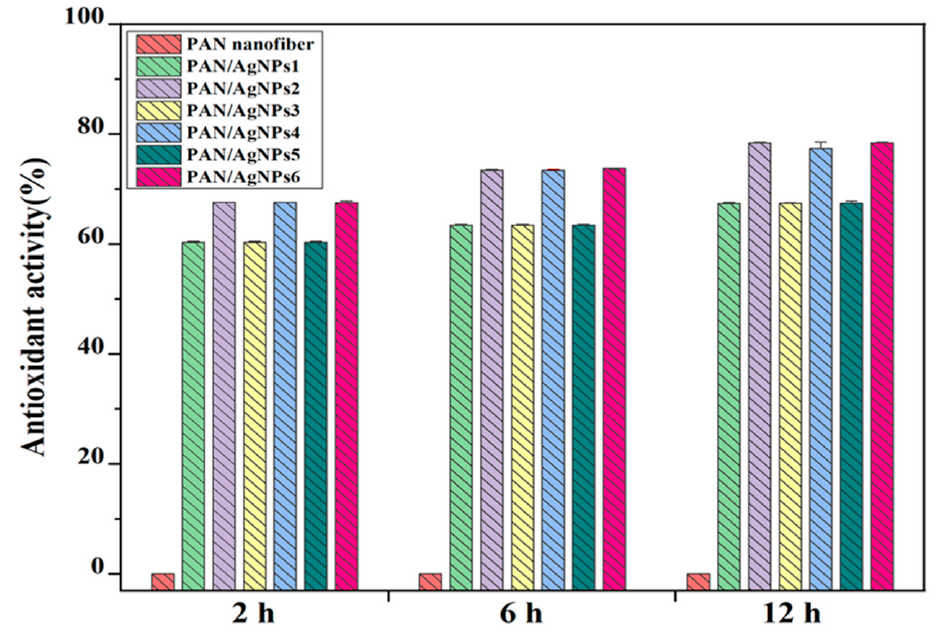
Figure 11. DPPH scavenging activity of PAN nanofiber, PAN/AgNPs1, PAN/AgNPs2, PAN/AgNPs3, PAN/AgNPs4, PAN/AgNPs5, and PAN/AgNPs6 measured by UV – visible spectro-